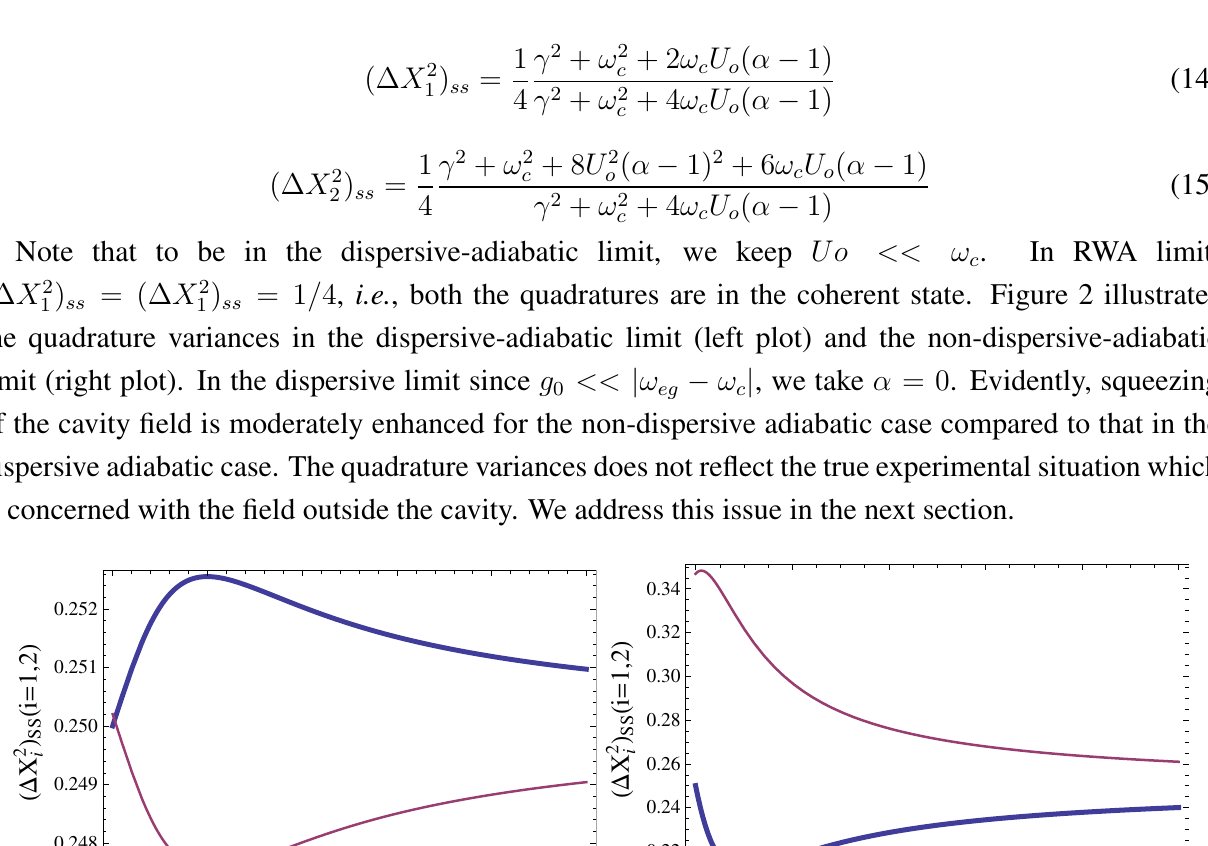
Figure 2. Left Plot: Plot of the variances versus ω = 1 . 1 γ and α = 1 . 2 . ∆ X 2 Plot: U 0